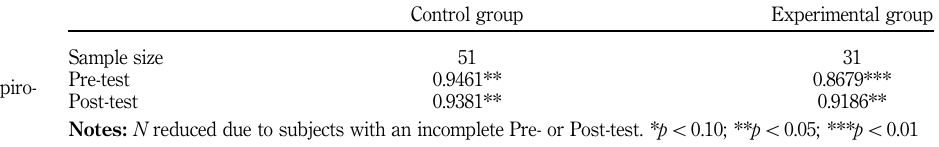
Figure 3. Data visualization from experimental group (role playing)